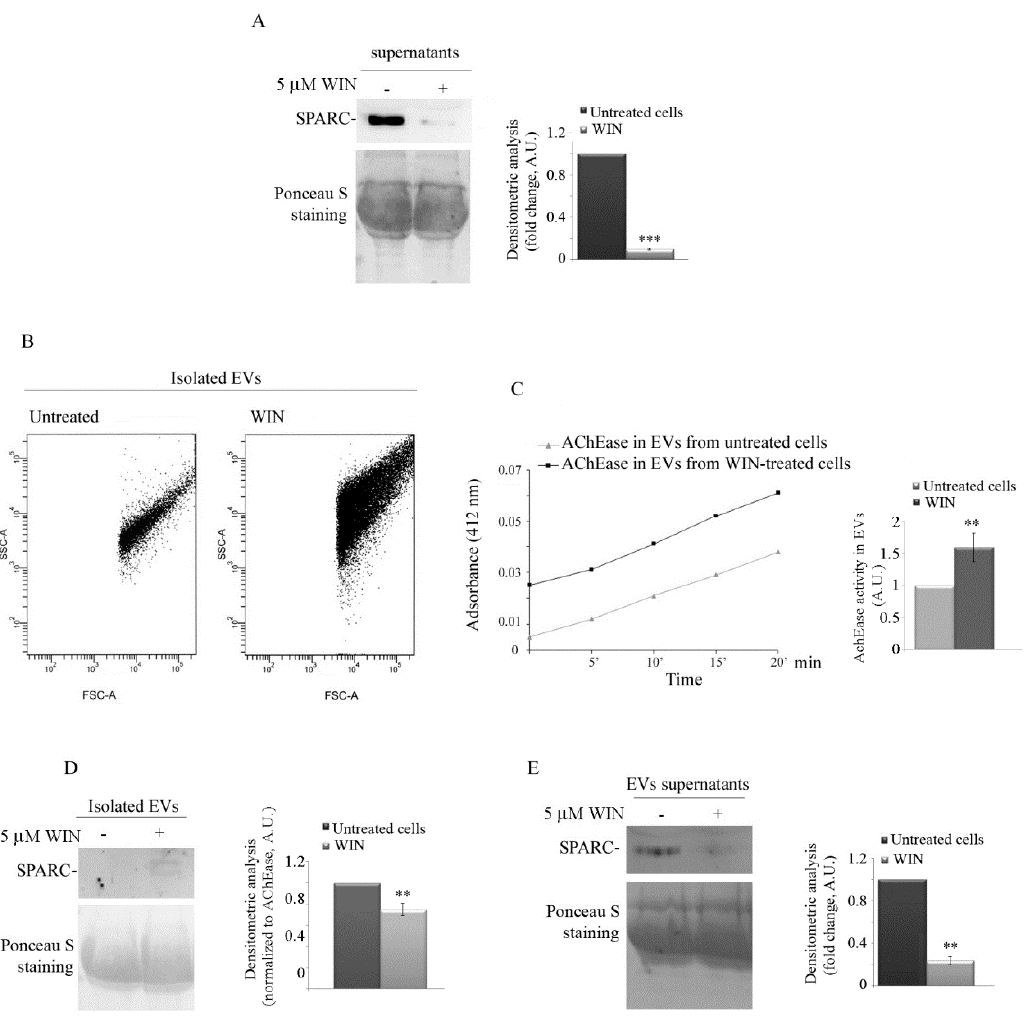
Figure 3. WIN treatment blocks secreted protein acidic and rich in cysteine (SPARC) release and increases the number of extracellular vesicles. ( A ) Western blotting analysis of SPARC in media derived from untreated or WIN-treated cells for 36 h. The media were dialyzed, concentrated by lyophilization, and reconstituted with water. Protein samples were separated under reducing conditions, and immunoblotting was performed using SPARC antibody. Red Ponceau staining was reported as loading control. The results are representative of three independent experiments and densitometric analysis is reported in the histograms. (***) p < 0.001 compared to untreated cells. ( B ) Flow cytometry analysis of isolated extracellular vesicles (EVs) derived from untreated or WIN-treated MG63 cells. Data are representative of three independent experiments. SSC, side scatter; FSC, forward scatter. ( C ) Acetylcholine esterase (AChEase) activity in EVs from untreated or WIN-treated cells assessed as reported in Section 4 and relative quantification. ( D , E ) Western blotting analysis of SPARC in MG63 cell-derived EVs. Media from untreated or WIN-treated cells were collected and EVs isolated as reported in Section 4. The immunoblotting of isolated EVs ( D ) or EV supernatants ( E ) was performed to detect SPARC level. AchE activity ( D ) and Ponceau red staining ( E ) were used as loading control. Representative blots of three independent experiments and densitometry analysis histograms are depicted. (**) p < 0.01 compared to the untreated sample.